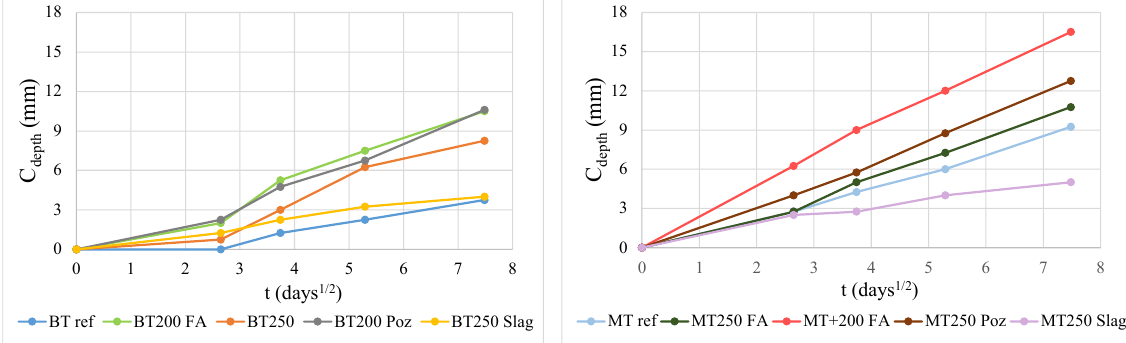
Figure 7. Carbonation depth of BT (left) and MT (right) mixtures.